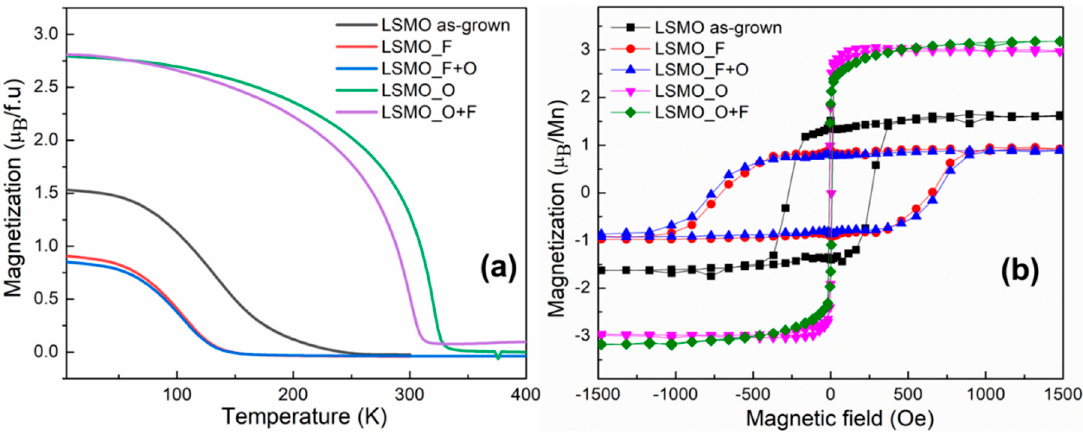
Figure 4. ( a ) Field-cooled magnetization measurements and ( b ) Field-sweep hysteresis loops of the investigated LSMO films measured at 5 K. The magnetization per Mn ion was estimated from the film thickness and is in fair agreement with previous findings for as-grown and oxidized films [11,23]. The obtained values of Curie temperature T C , saturation magnetization M S , and coercive field H C are listed in Table 3. According to the experimental results, incorporation of either oxygen or fluorine anions into the oxygen-deficient lattice of LSMO have a remarkable impact on the magnetic characteristics. The magnitude of the change in T C , M S , and H C indicate that anion intercalation affects a large portion of the LSMO volume, thus corroborating the results of the microstructural analysis. Table 3. Values of saturation magnetization ( M s), Curie temperature ( T c) and coercive field ( H c) as obtained from the magnetization measurements shown in Figure 4. Experimental errors are within 10% accuracy.